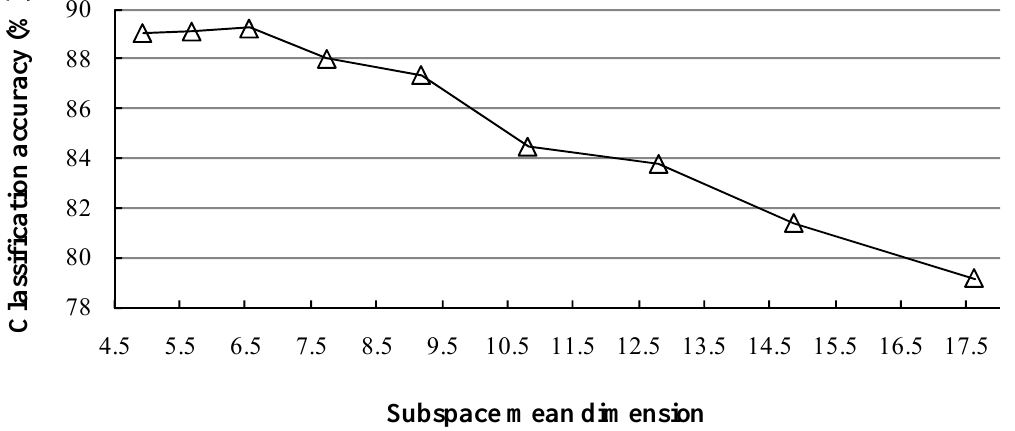
Figure 1. Plots of the classification accuracy and maximum training iterations as a function of the number of subspace dimensions by the dynamic and fixed subspace methods. (a) Classification accuracy by dynamic subspace vs. mean dimension, (b) Maximum learning iterations by dynamic subspace vs. mean dimension, (c) Classification accuracy by fixed subspace vs. subspace dimension, and (d) Maximum learning iterations by fixed subspace vs. subspace dimension. Dynamic dimension. Accuracy vs. mean dimension